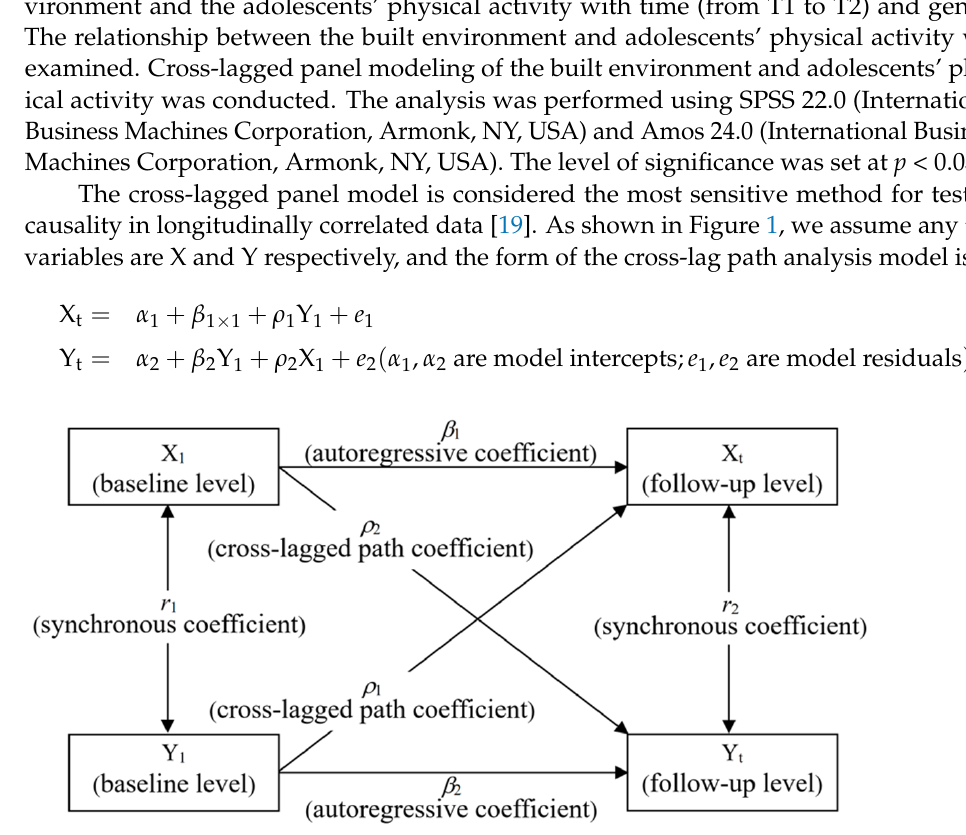
Figure 1. Cross ‐ lagged panel model. Figure 1. Cross-lagged panel